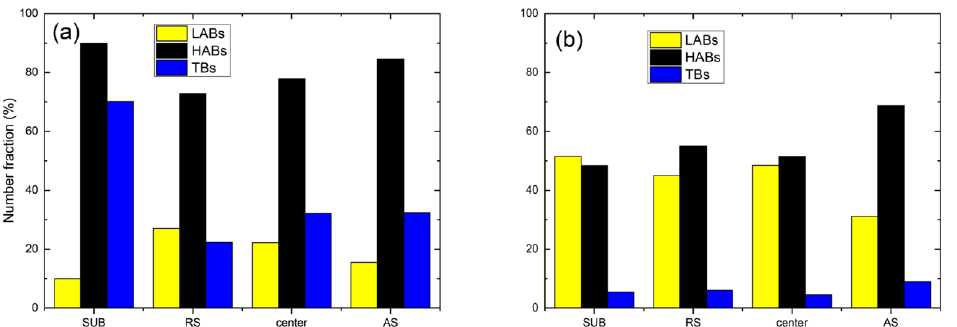
Figure 7. Grain boundary character distribution of SUB, RS, center, and AS: ( a ) γ / γ boundaries and ( b ) α / α boundaries (TBs: twin boundaries).